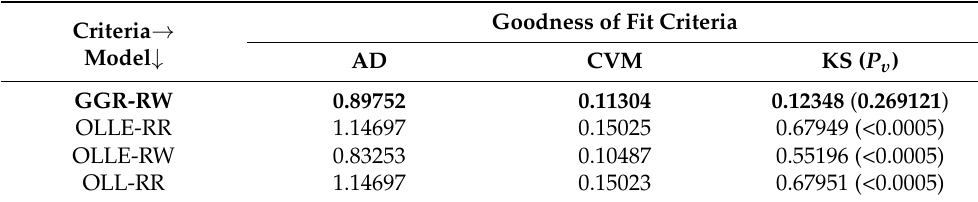
Figure 4. The NKDE panel (the first row, left panel), the TTT panel (the first row, right panel), the box panel (the second row, left panel), the Q-Q panel (the second row, right panel), scattergram panel (the third row, left panel), and the skewness-kurtosis panel (the third row, right panel) for the glass fibers data. Table 4. CVM, AD, KS and P υ for the glass fiber